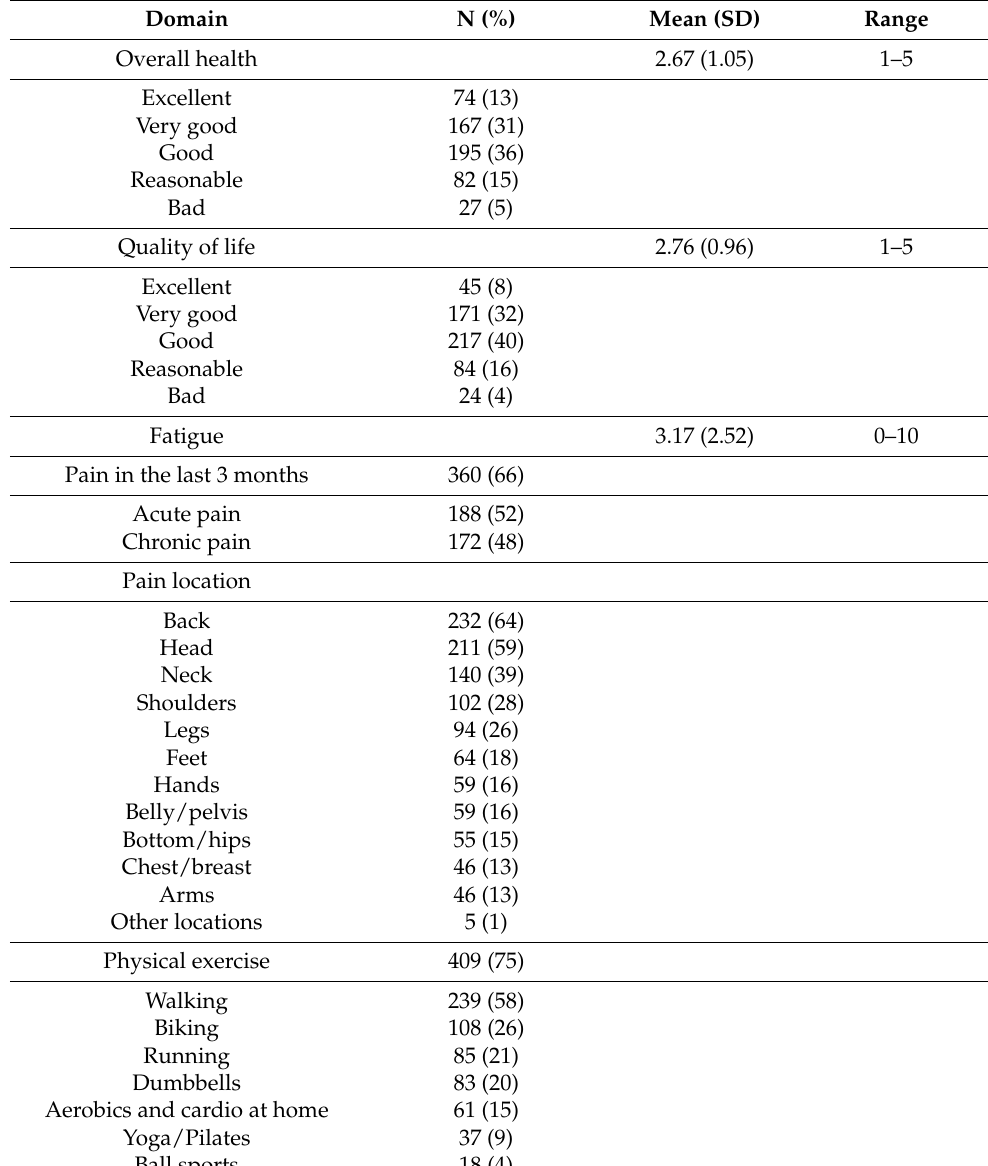
Table 4. Descriptor statistics for physical health-related variables (N=